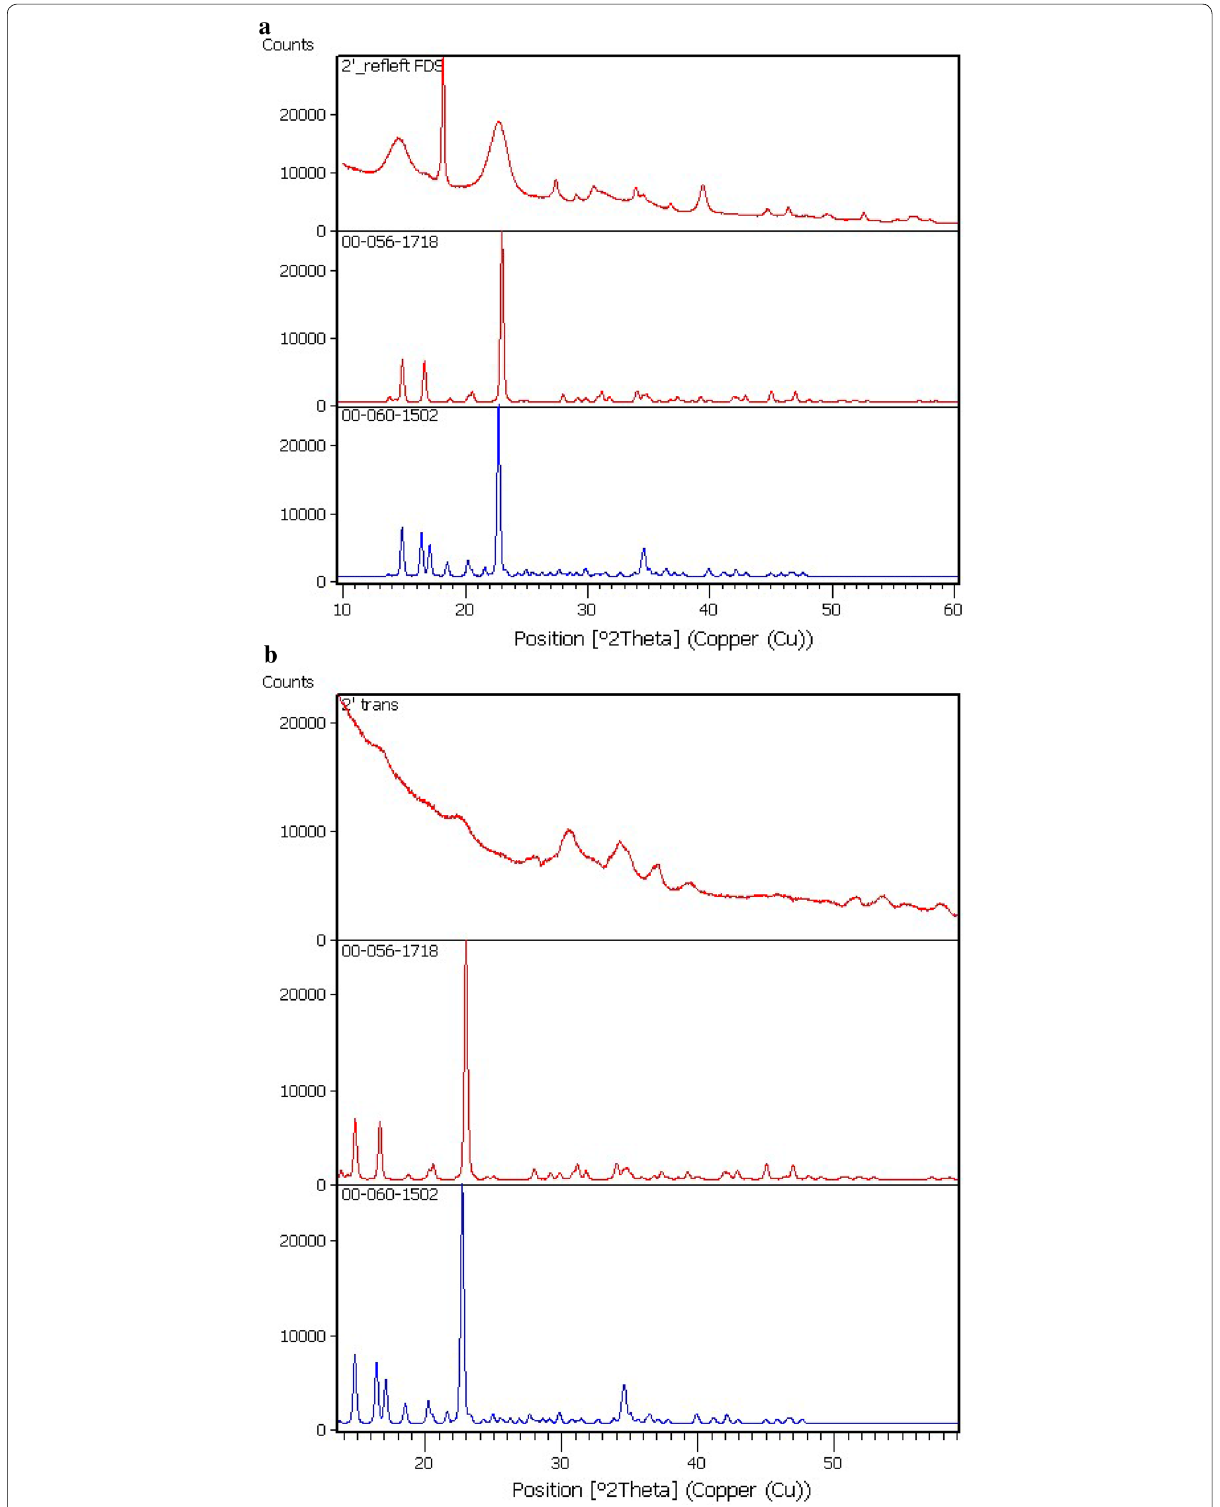
Fig. 7 X-ray diffractogram obtained from the BC sample (measurements were carried out in two setups: “reflection” ( a ) and “transparency” ( b